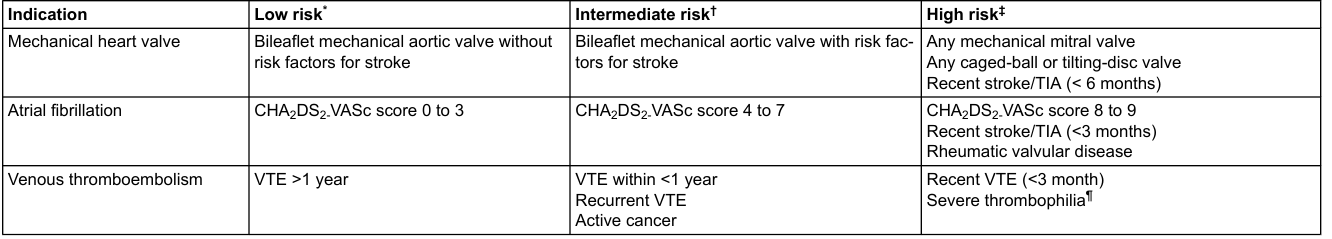
Table 1: Patient-related risk for thromboembolism according to anticoagulation indication; adapted from [38, 39].